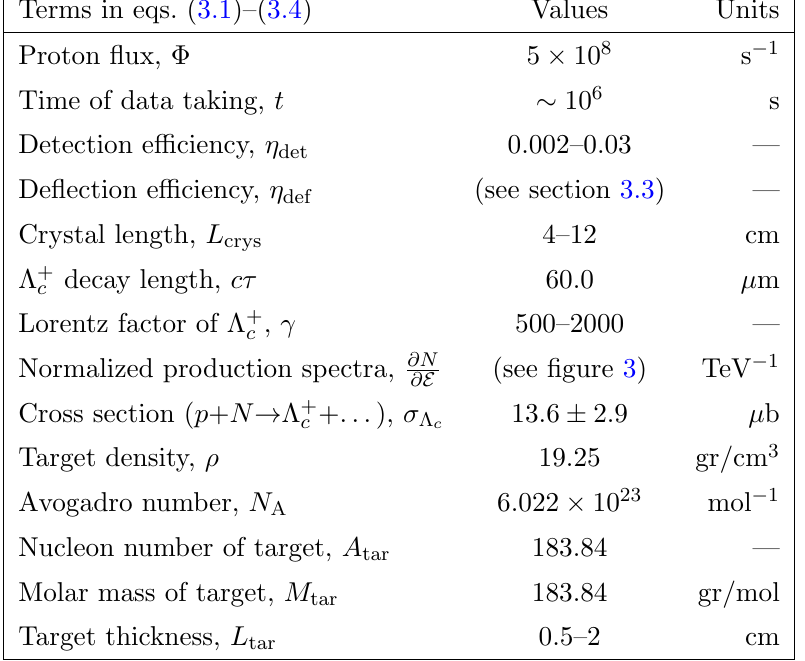
Table 2 . List of notations in eqs.